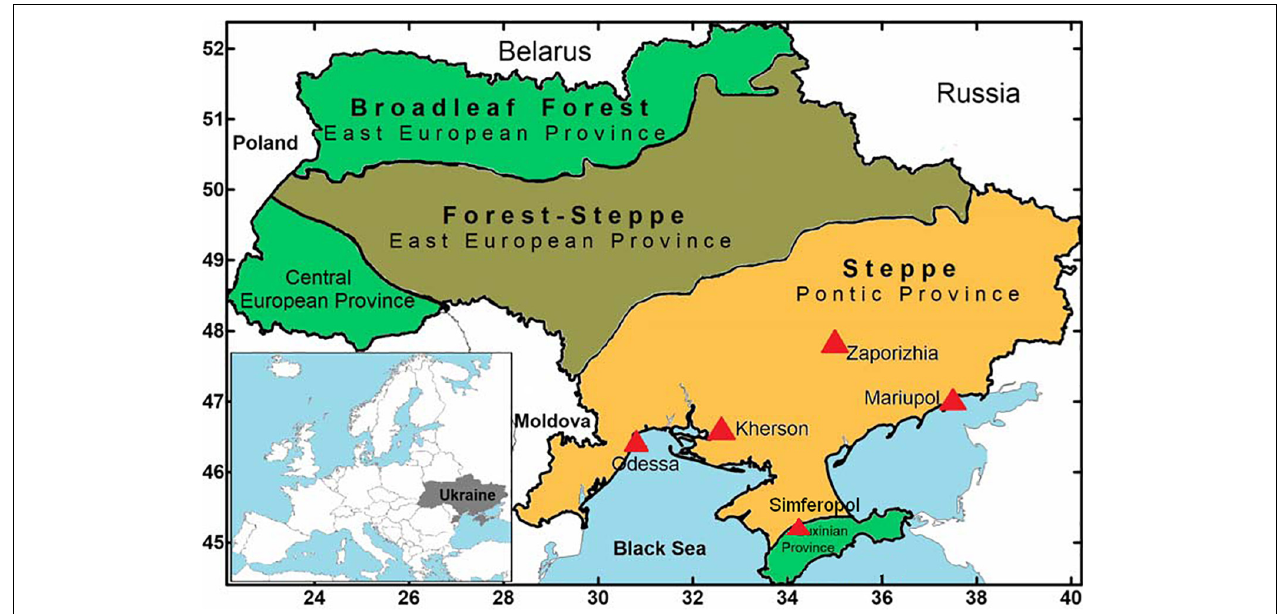
FIGURE 1 | The map of Ukraine with the location of meteorological stations (red triangles) in the Black Sea Steppe province, and schematic location the territory of Ukraine on the map of Europe. Frontiers Media SA remains neutral with regard to jurisdictional claims in published maps and institutional